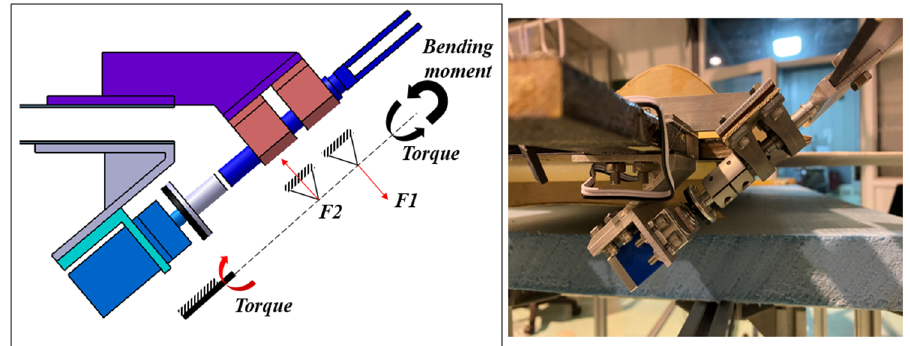
Figure 15. V-tail actuator and its force analysis process.